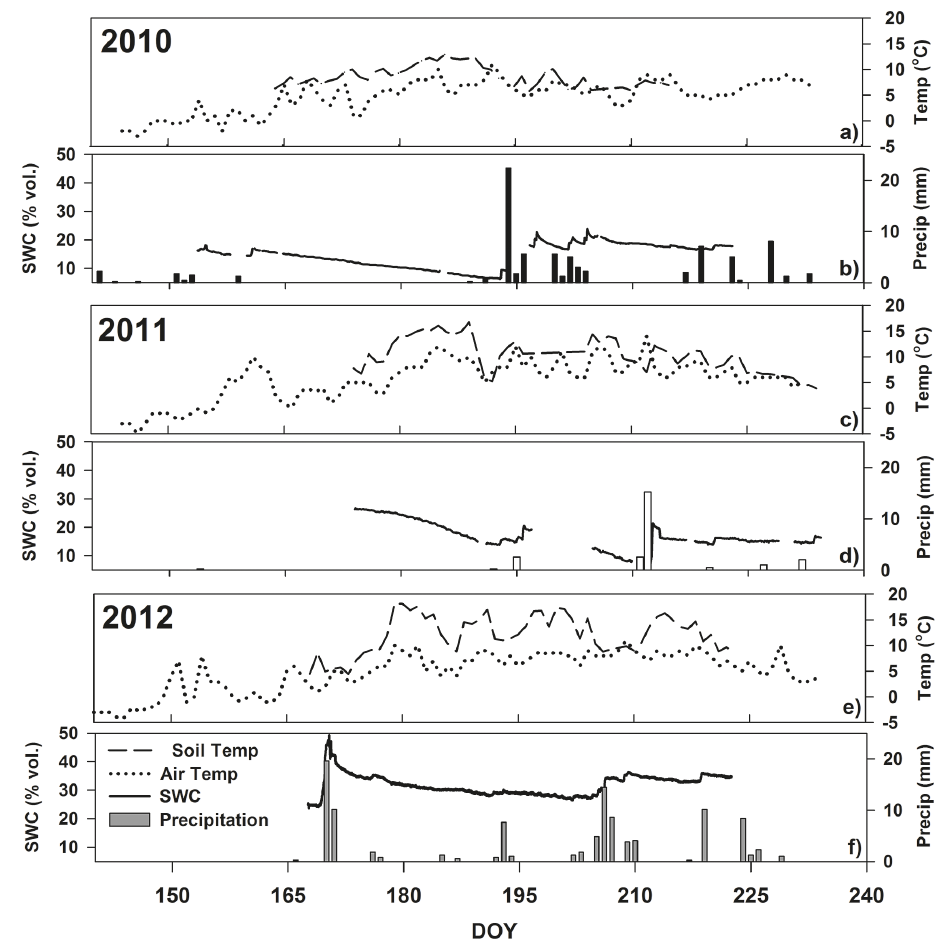
Figure 1. Seasonal patterns of soil temperature and SWC along with precipitation and air temperature in 2010 (a, b) , 2011 (c, d) and 2012 (e, f)